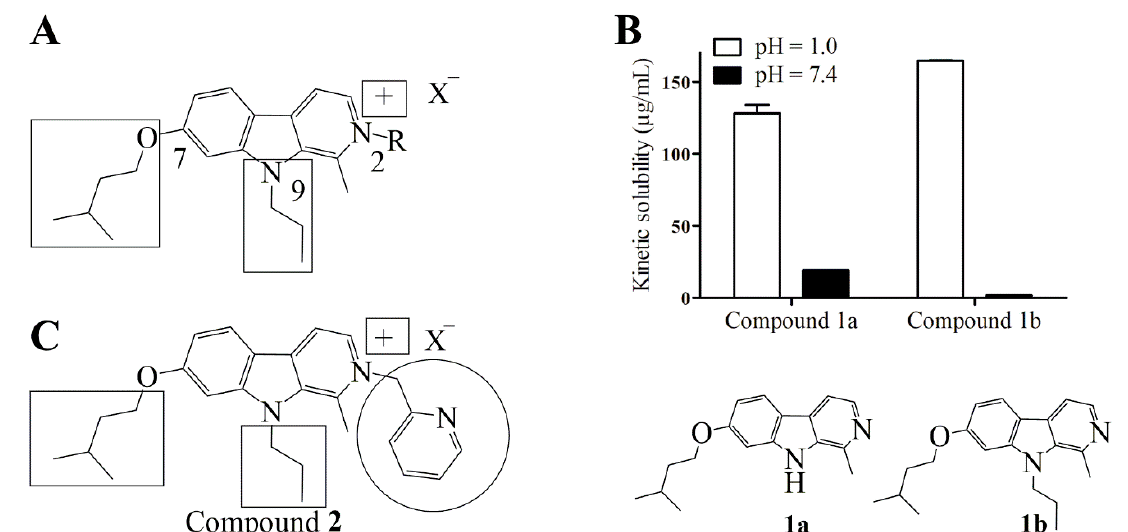
Figure 2. Design of a new β -carboline derivative. ( A ) Important structural elements to maintain antiproliferative activity (highlighted by black frames). ( B ) Preliminary kinetic solubility data of mono- and di-substituted compounds 1a and 1b. ( C ) Proposed novel trisubstituted harmine derivative keeping structural elements necessary to maintain good antiproliferative activity (black frames) while adding a pyridyl moiety that should lead to improve solubility (black circle).